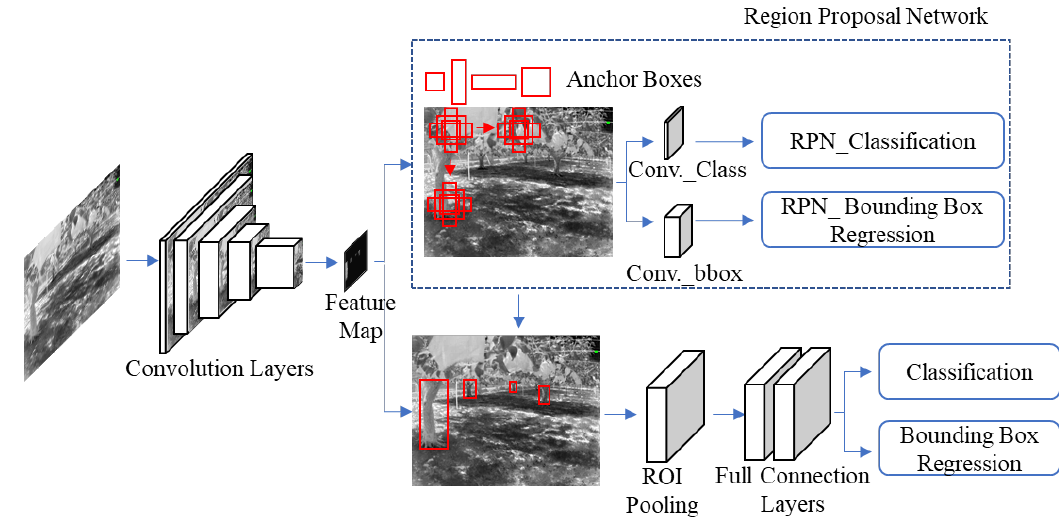
Figure 5. Faster R-CNN network structure-focusing regional proposal network for feature map.